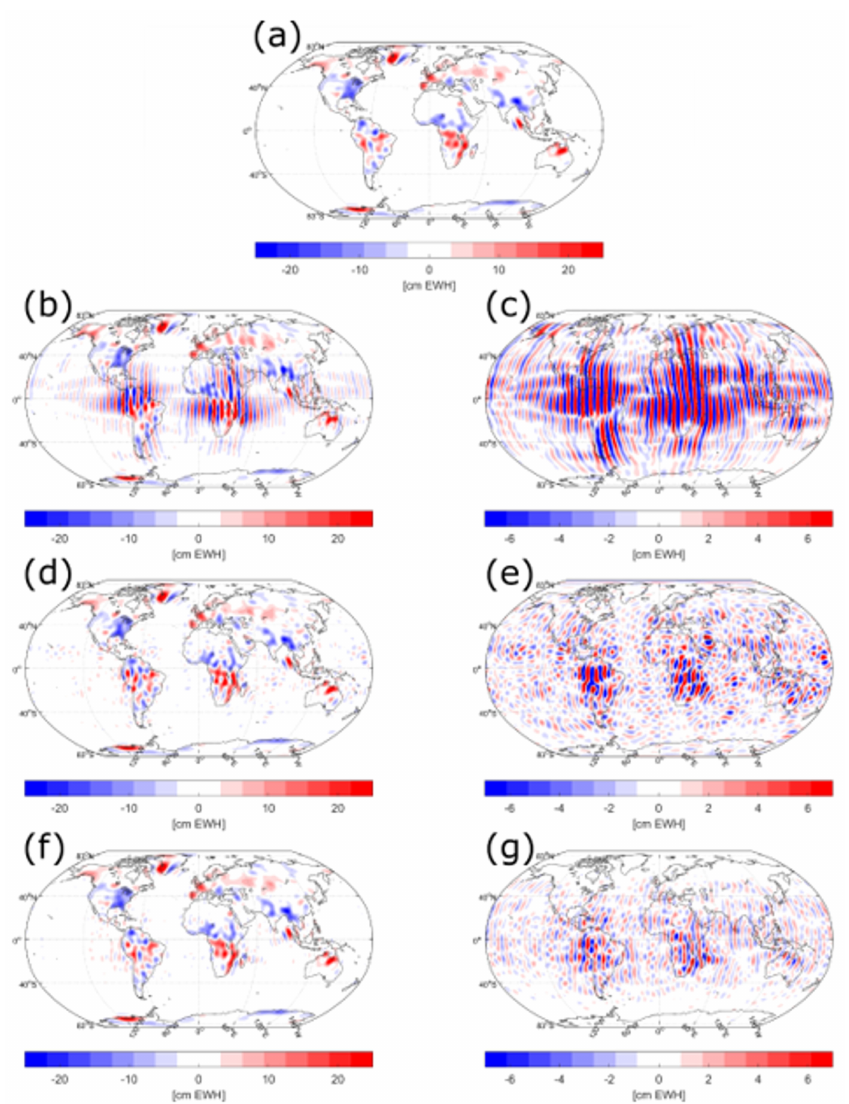
Figure 9. Global grids of EWH (cm) up to SH degree and order 50 after 1 month. The grids show the true HIS signal ( a ), the recovered signal ( b , d , f ), and the differences of the true HIS signal and the recovered signal ( c , e , g ), for the low–low pair configuration ( b , c ), for the MOBILE concept ( d , e ), and for the MOBILE concept using the extended processing method ( f , g